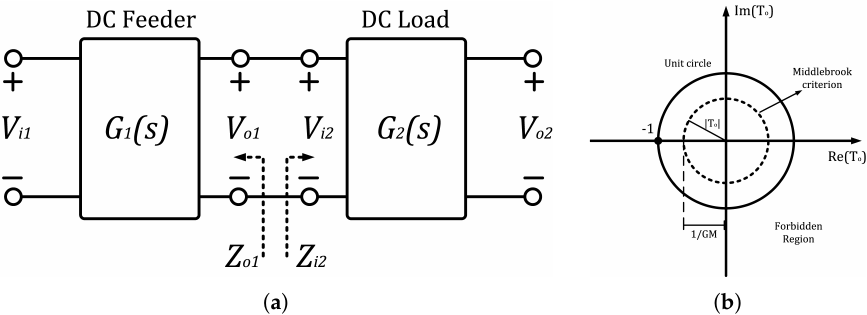
Figure 4. ( a ) Diagram of a DC distribution system. ( b ) Region determined by the Middlebrook criterion. Among the aforementioned criteria, the Middlebrook criterion determines the smallest stability